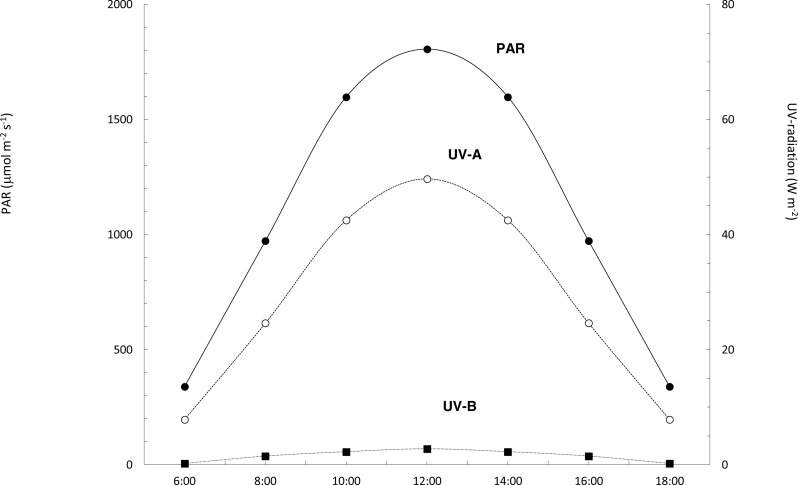
Daily course of PAR, UV-A and UV-B solar radiation.Daily course of PAR (black circles, continuous line), and UV-A (white circles, dotted line) and UV-B (black squares, dotted line) radiation at Tarifa, on 16th July 2011.